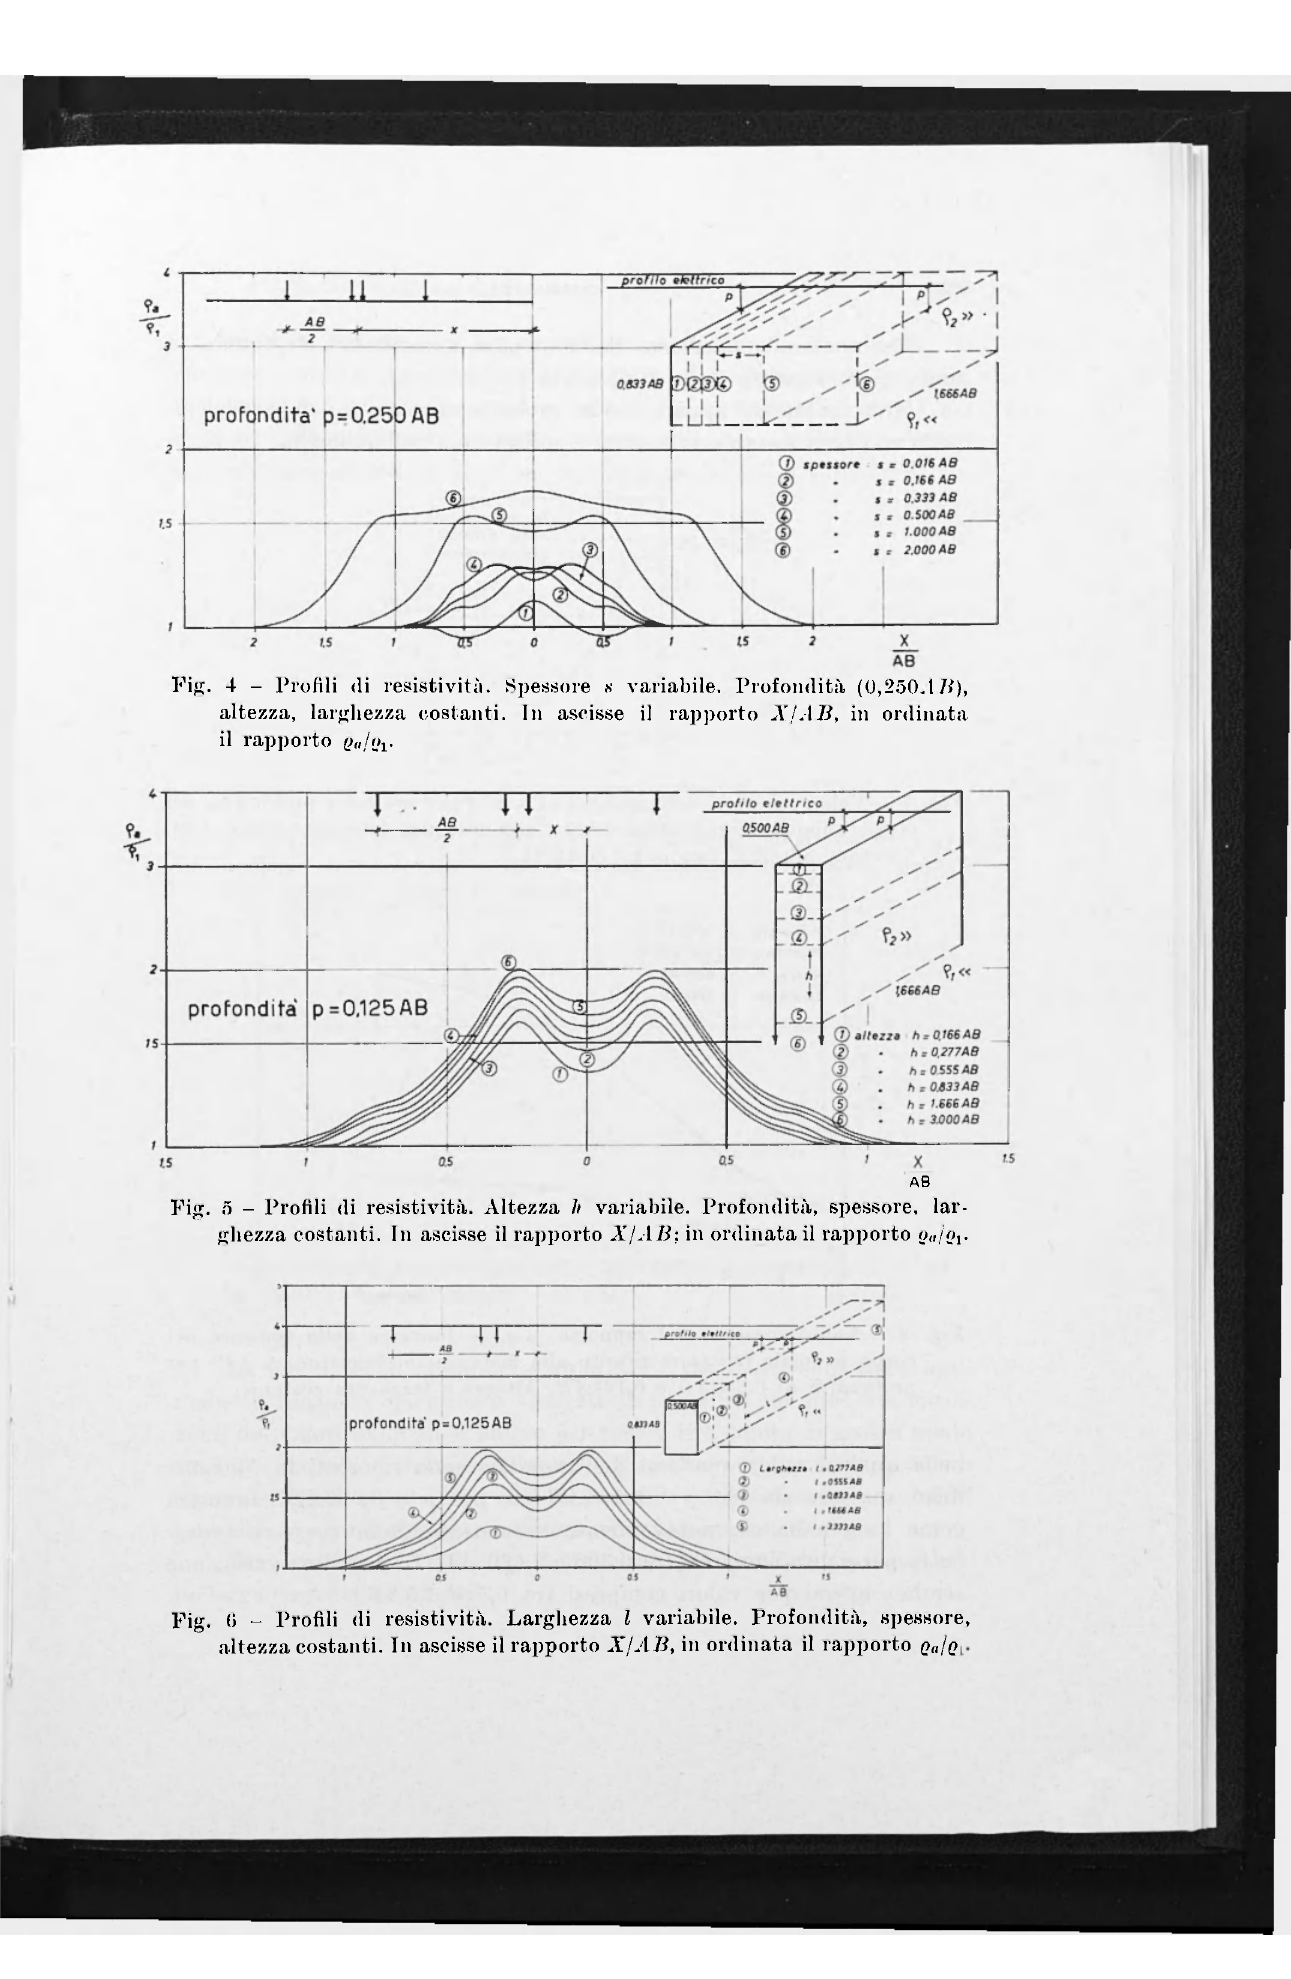
Fig. (i - Profili di resistività. Larghezza l variabile. Profondità, spessore, altezza costanti. In ascisse il rapporto X/AB, in ordinata il rapporto